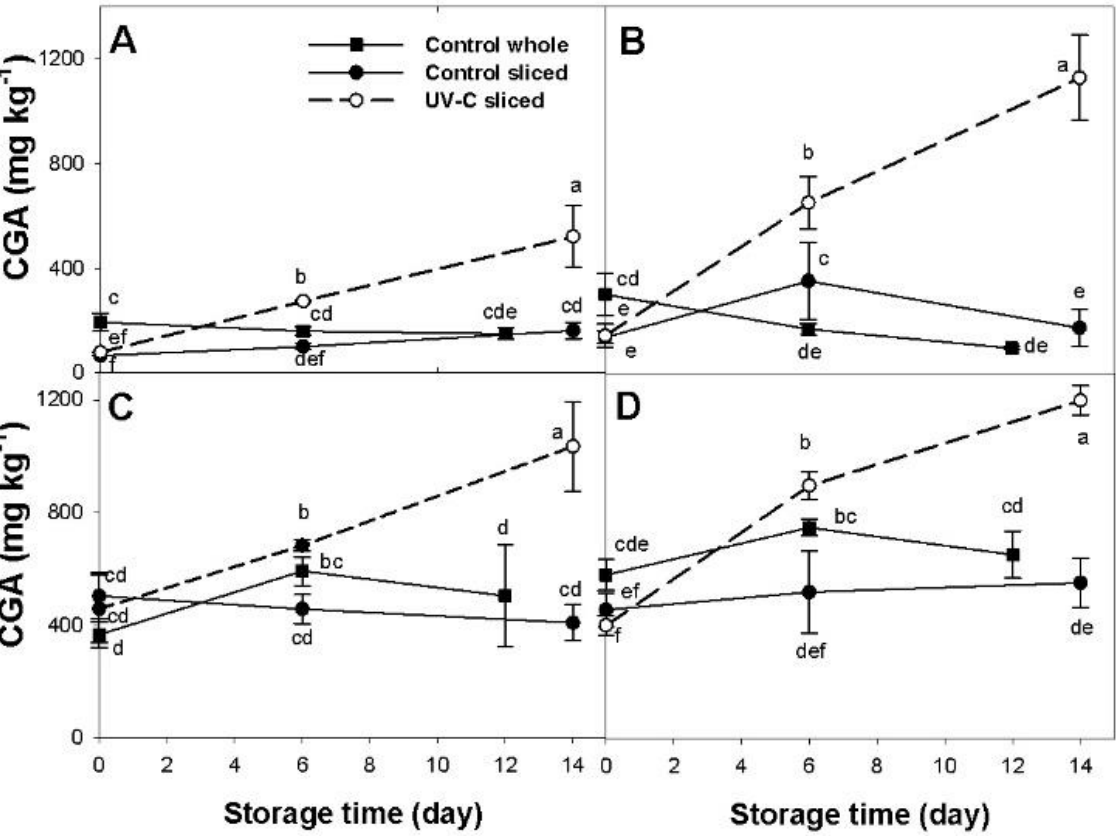
Figure 5. Time-course variation for chlorogenic acid (CGA) content in UV-C treated (- - ○ - -) and untreated (control) (- ● -) sliced roots and in untreated whole roots (- ■ -) of the orange-rooted cultivar ‘Maestro’ ( A ), the yellow-rooted ‘Uzbek Golden’ ( B ), and the purple-rooted ‘Purplesnax’ ( C ) and ‘INTA44’ ( D ) during cold storage at 5 ◦ C. Values are expressed as mg × kg − 1 fw. Error bars represent standard deviation of the mean. Means not sharing a common letter are significantly different at p < 0.05, Fisher test.